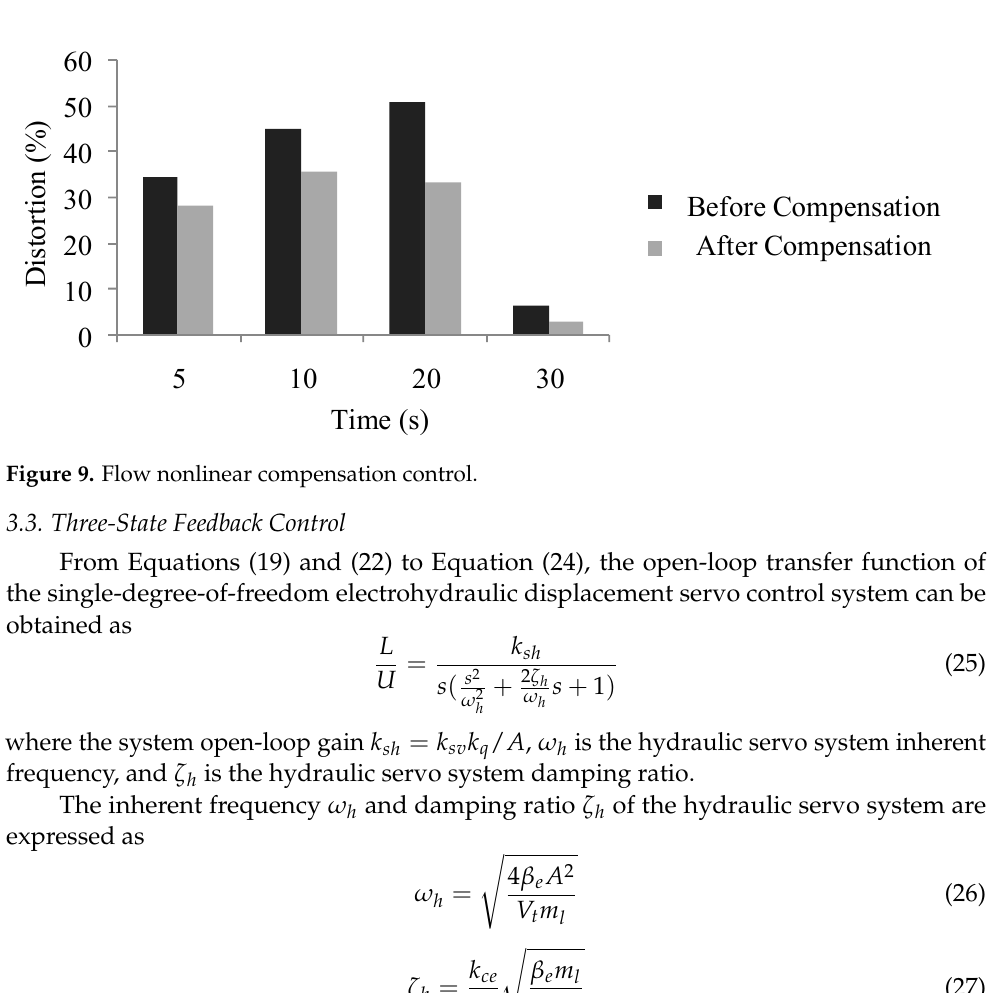
Figure 8. Effect of nonlinear compensation control: ( a ) 5 Hz, ( b ) 10 Hz, ( c ) 20 Hz, ( d ) 30 Hz.